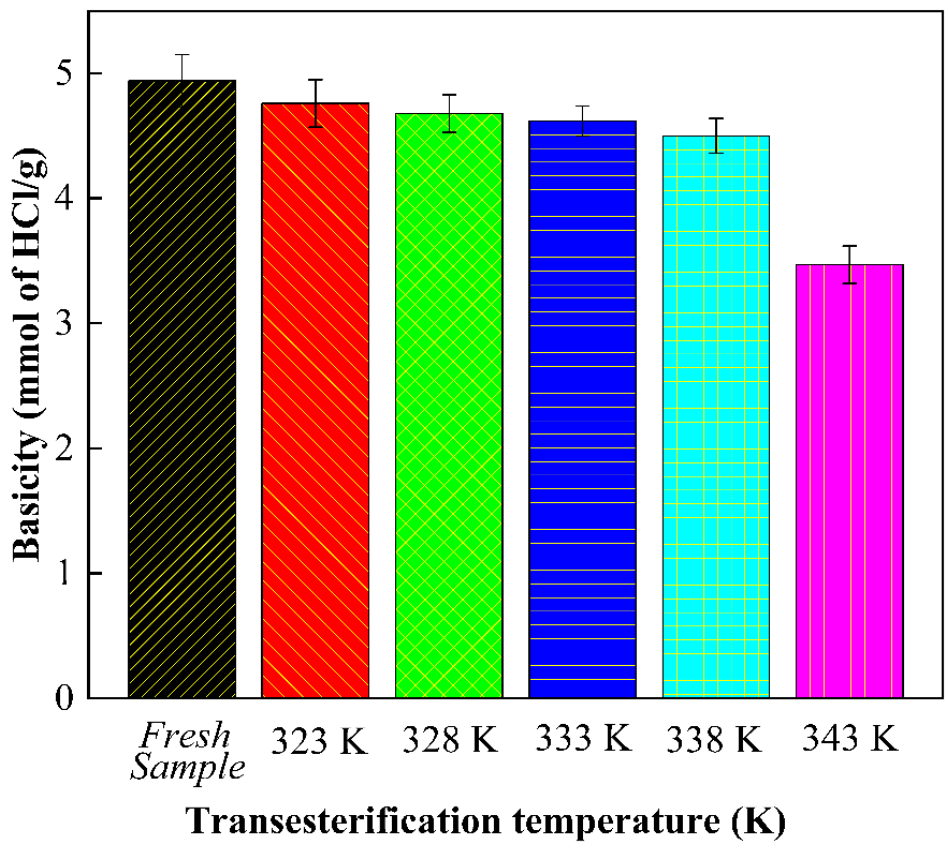
Figure 4. The basicity of used CaNa/AC at different temperatures.